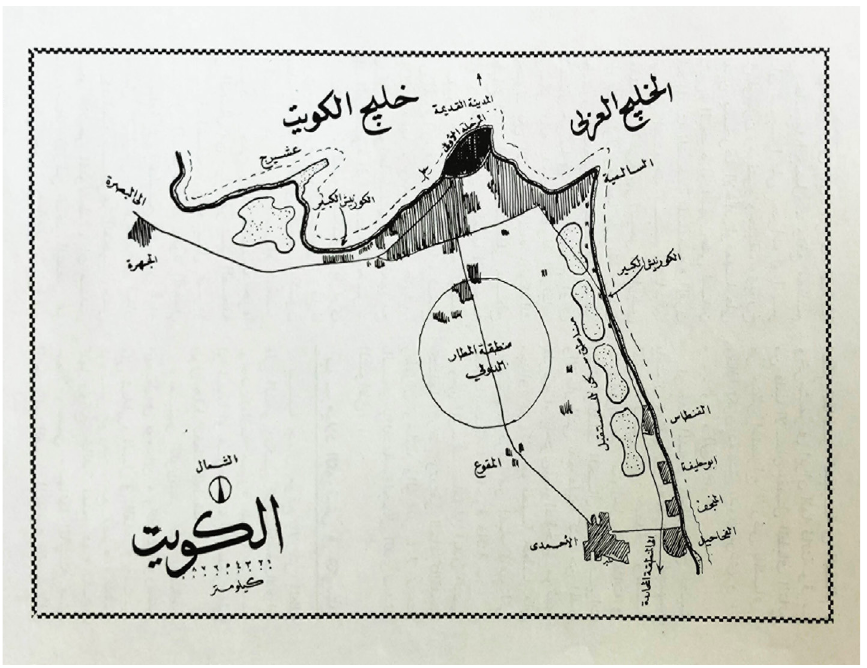
Fig. 9 Shiber Plan for Kuwaitapolis explaining the concept of fortification as an urban land - scaping of the new residential suburbia along the coastline south. Source: Saba Shiber, The Kuwait Urbanization (Kuwait: Kuwait Government Printing Press,